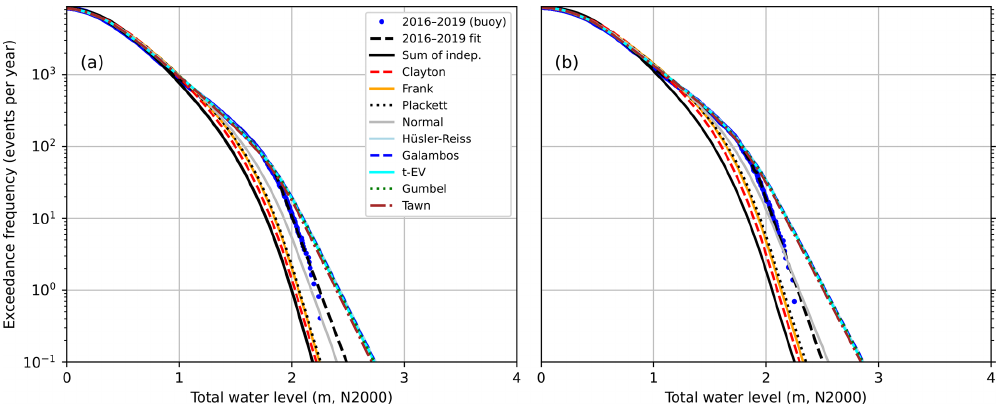
Figure 7. The observation-based CCDF of total water level during 2016–2019 (“buoy” + “fit”), the CCDF calculated assuming the variables independent (“Sum of indep.”), as well as CCDFs calculated by taking 10 8 random samples based on the nine different copulas combined with the observation-based marginal distributions for (a) all data and (b) situations with southwesterly wind (160–340 ◦